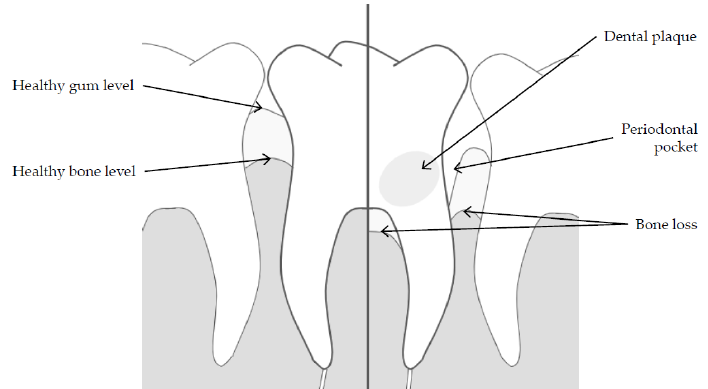
Figure 2. Schematic representation of the suspension apparatus of a human tooth, illustrating periodontal pocket. In the left part of the picture there is a healthy tooth; in the right, a tooth with periodontitis. The true periodontal pocket is caused by the loss of tooth attachment; it is deeper than 3.5 mm. Other symptoms of the disease are changes in the position of the teeth and their